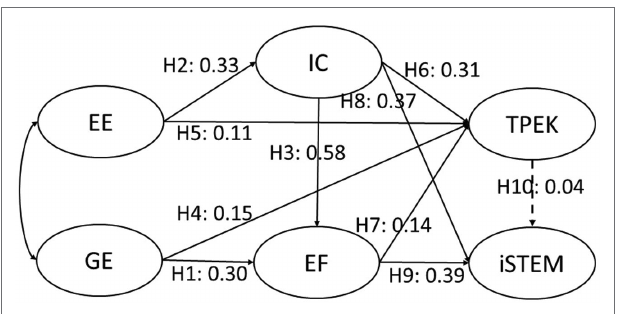
FIGURE 2 | The structural model of the measured variables.